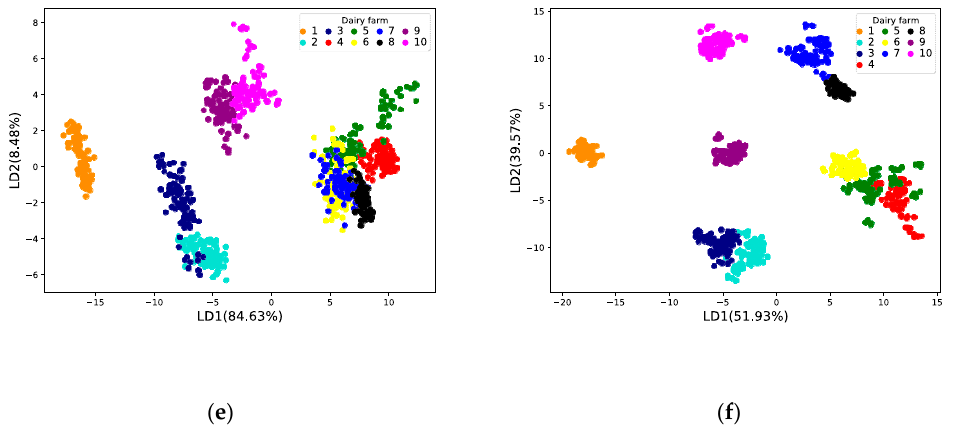
Figure 4. Visualization of data dimensionality reduction: ( a ) Daily Herd Improvement (DHI) data dimension reduction results by Principal Component Analysis (PCA); ( b ) E-nose data dimension reduction results by PCA; ( c ) Fusion data reduction results by PCA; ( d ) DHI data dimension reduction results by Linear Discriminant Analysis (LDA); ( e ) E-nose data dimension reduction results by LDA; ( f ) Fusion data reduction results by LDA.